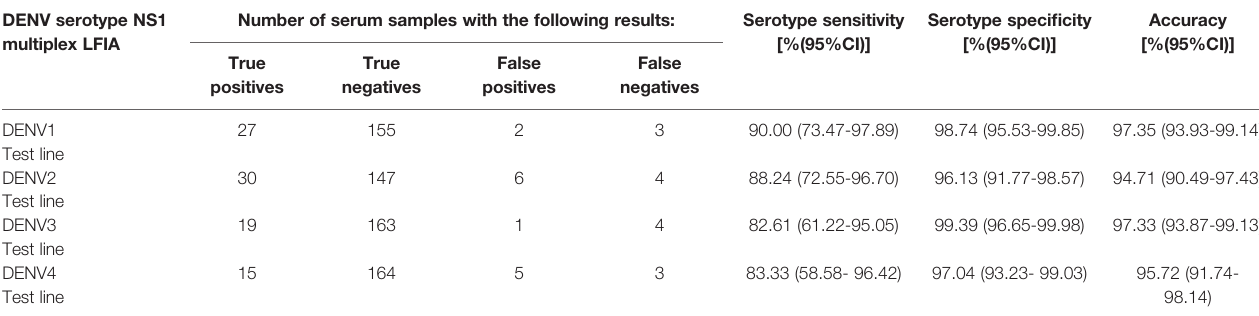
TABLE 7 | Serotype speci fi city and sensitivity of DENV serotype NS1 multiplex LFIA for detection of NS1 in acute-phase sera (n=187). DENV serotype NS1 Number of serum samples with the following results: multiplex LFIA